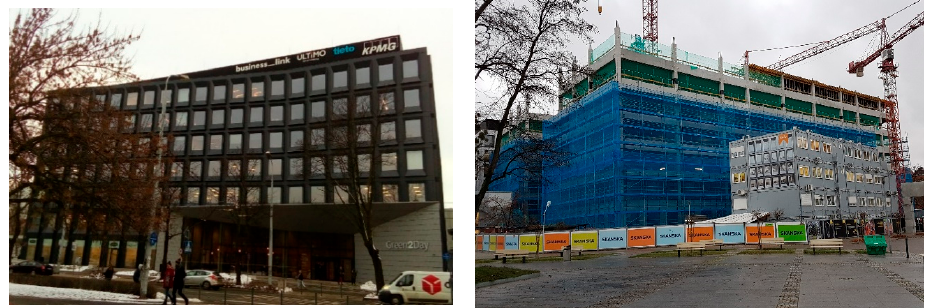
Figure 2. “Green2Day” o ffi ce building front view. Investor: Tenali Investments Ltd. and Trikala SCA. Designers: Ma´ck ó w Pracownia Projektowa LP & Grupa Projektowa Konstruktor Ltd. Own study.